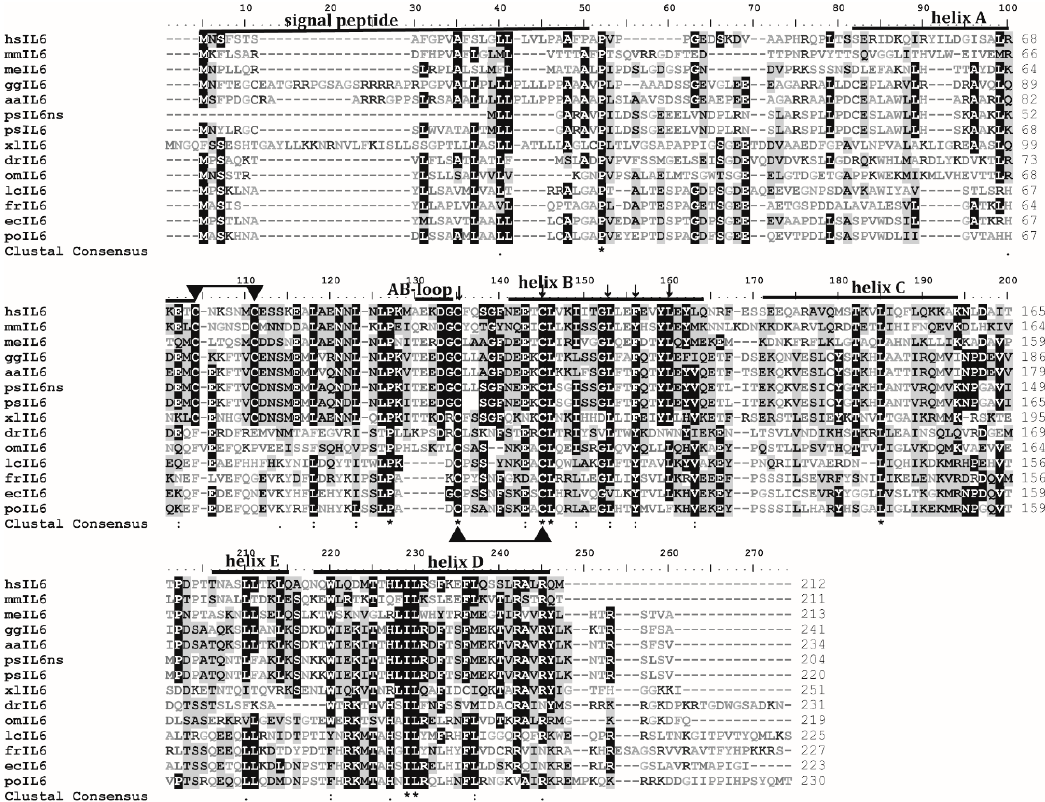
Figure 2. Multiple sequence alignment of the deduced IL6 in the Chinese soft-shelled turtle and other selected animals. The consensus residues are shaded. In the consensus line, asterisks (*) resemble completely identical residues in all selected species, and dots (.), and colons (:) represent similarity. MUSCLE program was used for the alignment. Accession numbers of genes are supplied in Supplementary Table S4 and the first two letters of the sequence name represent the initial letters of species’ Latin name. Signal peptide, Helix A-E, and AB loop of human IL6 are clearly denoted. Conserved cysteines are indicated with triangles and putative disulfide bonds are linked with single lines. Critical amino acid residues in the IL6/G-CSF/MGF family signature characteristics were labeled with solid arrows.